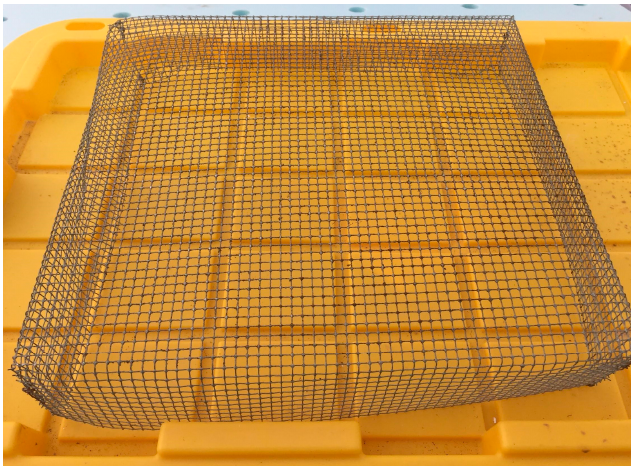
Figure 5. Metal mesh sieve used to remove clumps and ensure loose filling.